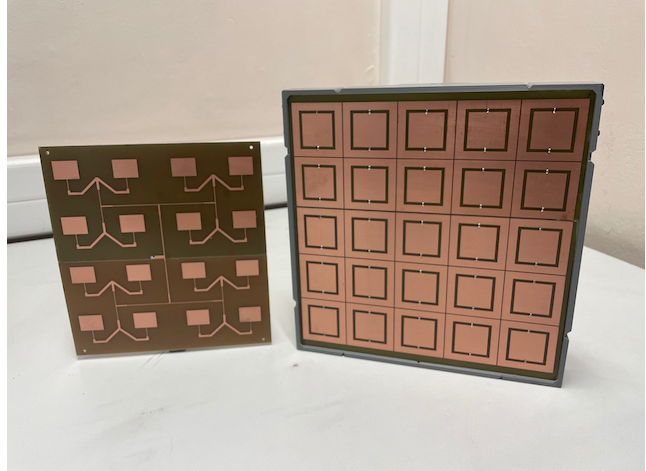
Figure 6. Microstrip feeding antenna ( left ) and transmitarray ( right )